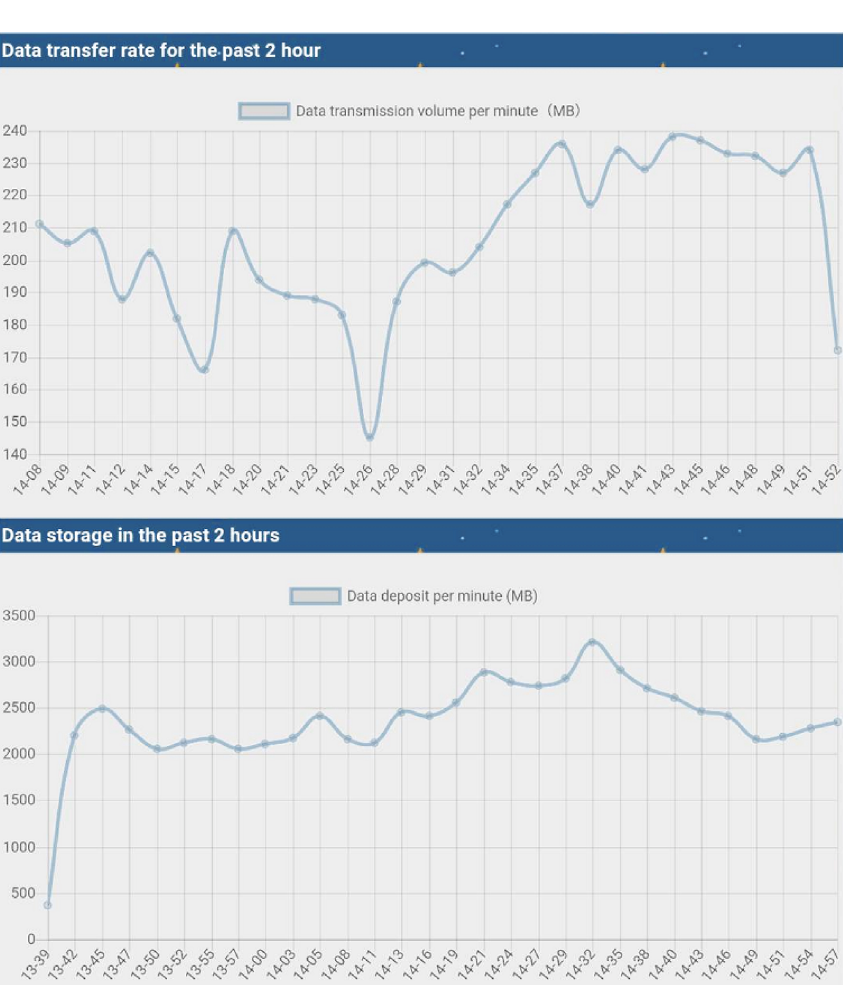
Figure 13: The fifth part of visualization web